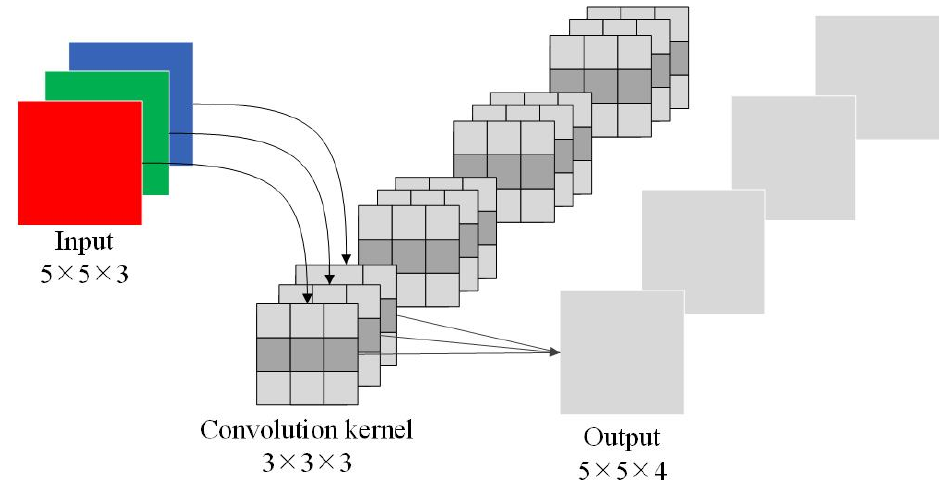
Figure 1. Schematic diagram of the ordinary convolution process.